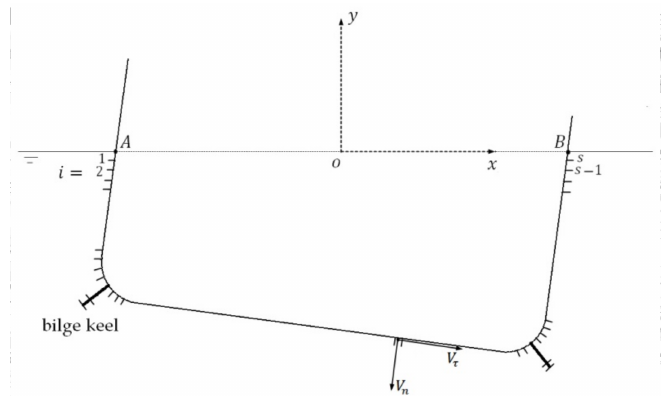
Figure 1. The coordinate system o − xy and a hull section with bilge keels. The hull section harmonically rolls on the water surface. A and B are water surface—hull wetted surface intersections. The wetted surface of the hull section is discretized into s